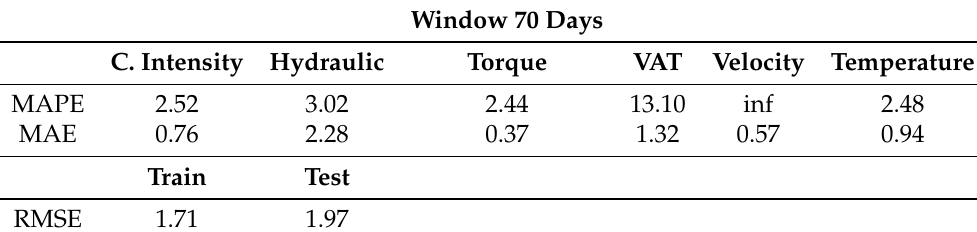
Table 3. Forecast results with treatments in the database with 40 LSTM